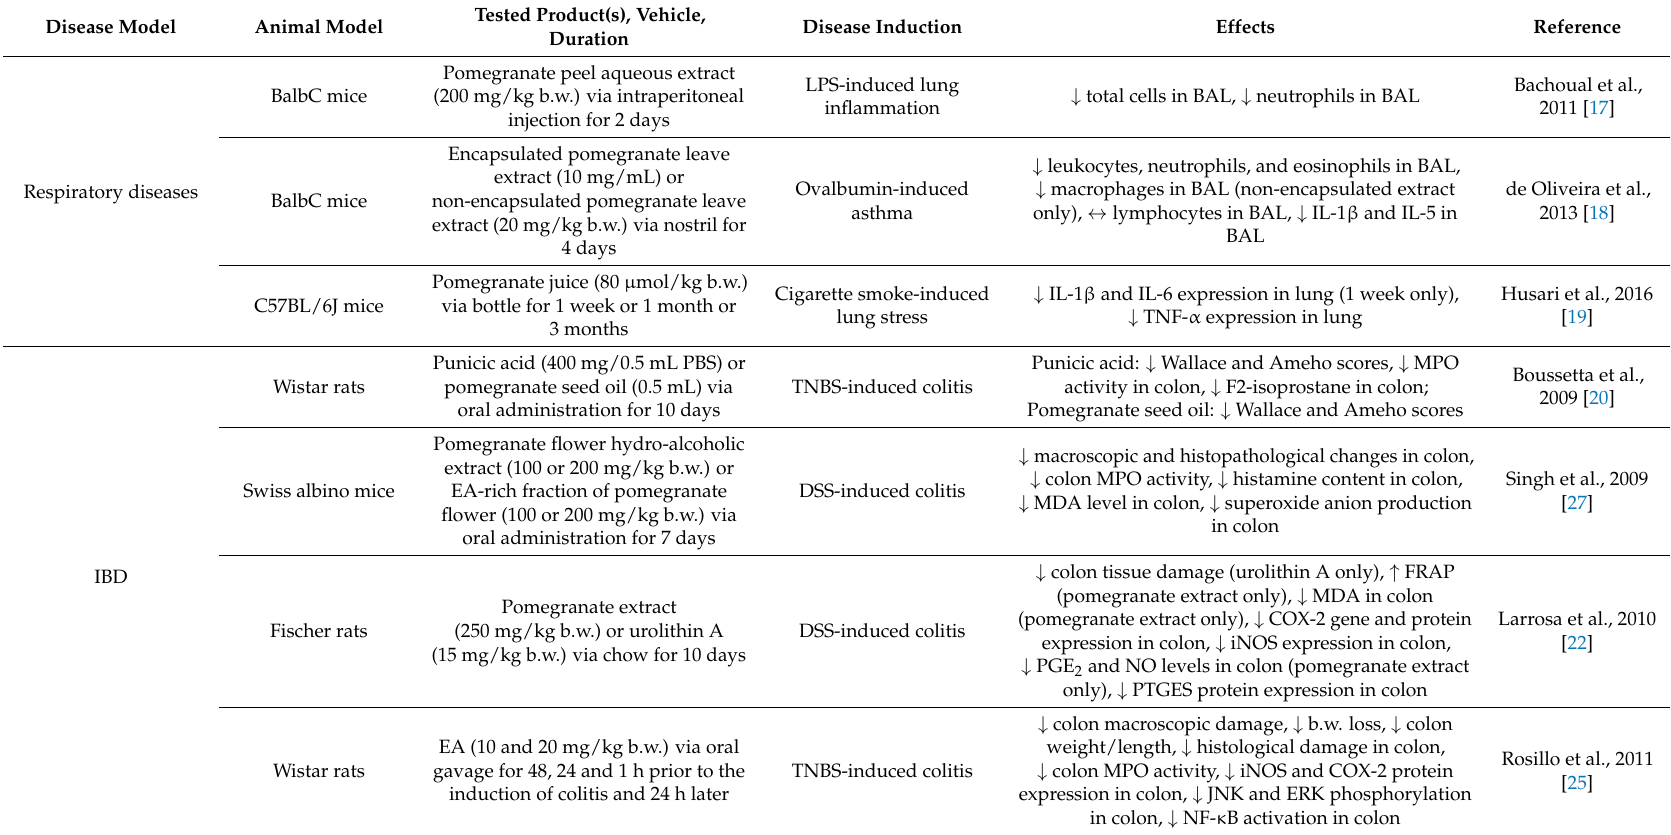
Table 4. Overview of the anti-inflammatory effects of pomegranate or pomegranate-derived products in animal models of